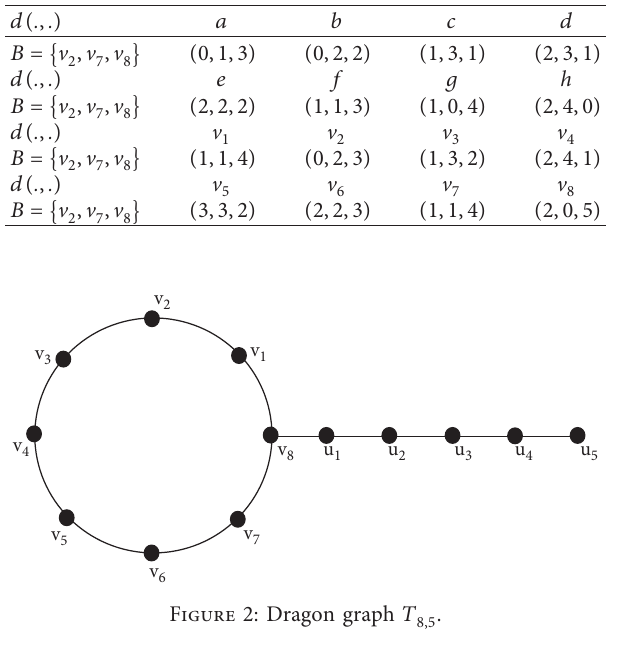
Table 2: Mixed distance codes of Γ w.r.t. B